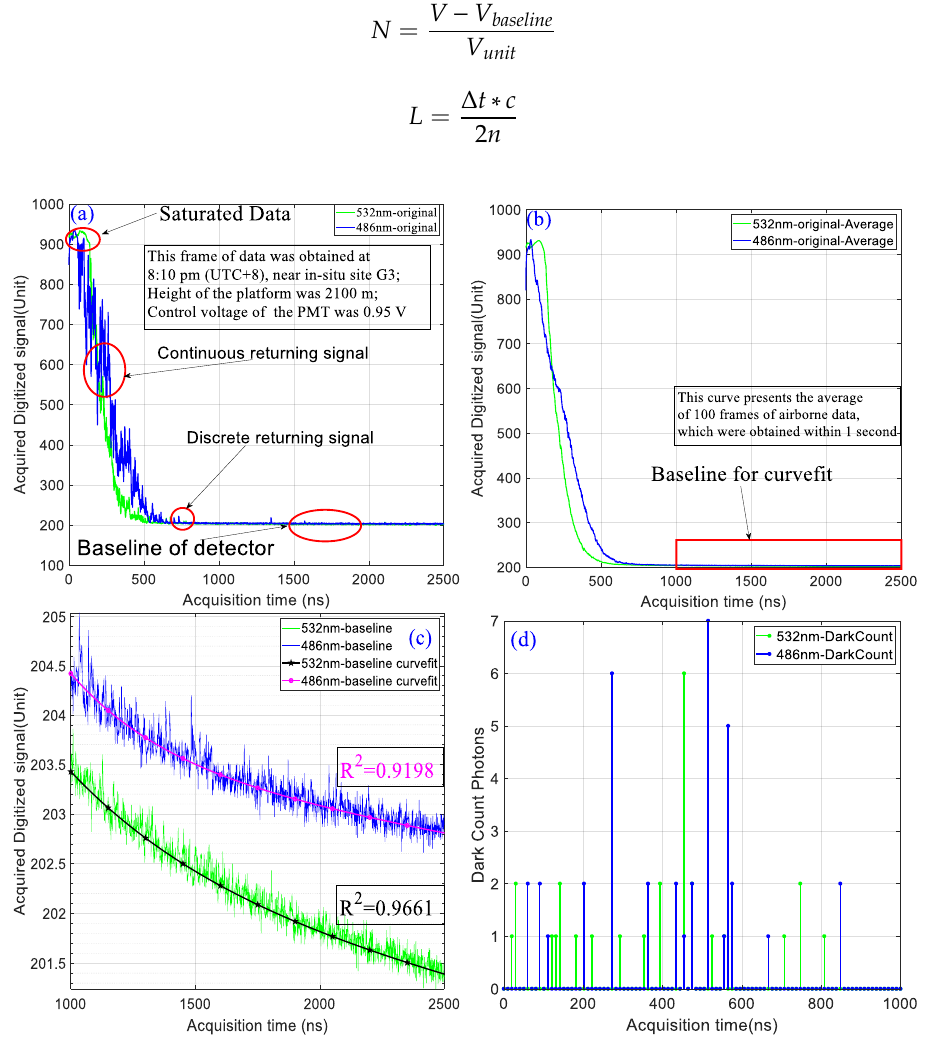
Figure 4. ( a ) Data for a single frame acquired by the acquisition board. Data obtained near in situ site G3 , for a photomultiplier tube (PMT) control voltage of 0.95-V and a plane height of 2100 m; ( b ) average result for 100 frames of data acquired within 1 s near G3 . Data acquired after 1000 ns were used as a curve-fit for the detector system baseline; ( c ) curve-fit results for the baselines of 532- and 486-nm channels. R-square values for 532- and 486 nm channels are 0.9661 and 0.9198, respectively; ( d ) dark count statistics for 532 and 486 nm channels, which were obtained without the laser.